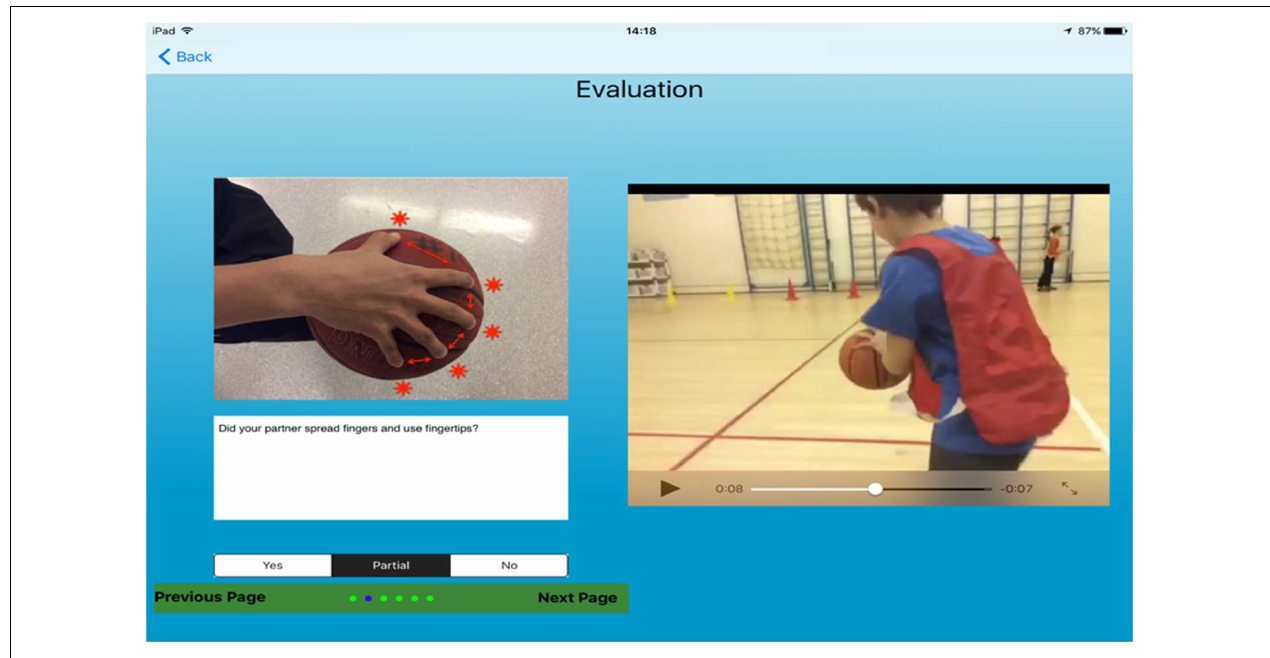
FIGURE 1 | Structured video data